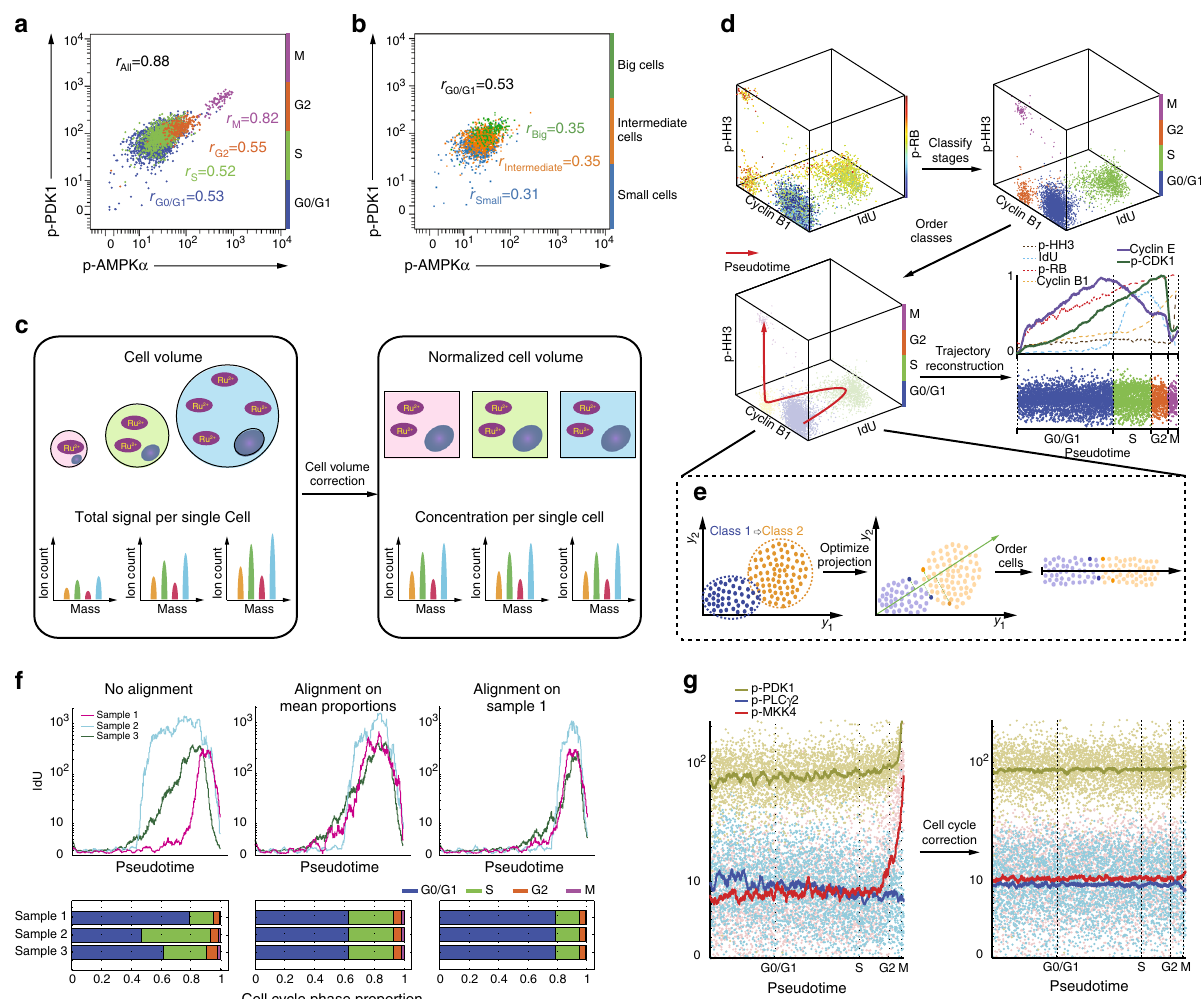
Fig. 1 Cell-volume and cell-cycle biases in mass cytometry data and their corrections using CellCycleTRACER. a Biaxial plot of p-PDK1 (Ser241) vs. p- AMPK α (Thr172) in THP-1 cells, where pre-gated cell-cycle phases are indicated by different colors. Computation of Pearson correlation coef fi cients across cell-cycle phases indicates a strong cell-cycle bias. b Biaxial plot of p-PDK1 (Ser241) vs. p-AMPK α (Thr172) in G0/G1 phase THP-1 cells that were pre- gated by cell volume as indicated by different colors. Pearson correlation coef fi cients are indicative of the cell-volume bias. c Cell-volume correction using ASCQ_Ru measurements removes cell-volume variability and transforms raw counts of measured markers into relative concentrations at single-cell resolution. d Construction of cell-cycle pseudotime initiates with automatic classi fi cation of the cells into discrete cell-cycle phases using measurements of IdU, cyclin B1, p-HH3, and p-RB25. The optimal trajectory across phases is constructed by projecting the data in a one-dimensional embedding function analogous to cell-cycle pseudotime. Mean trajectories of all measured cell-cycle markers across the reconstructed pseudotime recapitulate known behavior. Markers used to construct the pseudotime (IdU, cyclin B1, p-HH3, and p-RB) are shown as dashed lines, additional cell-cycle markers used as validation (cyclin E and p-CDK1) are shown as solid lines. e Simpli fi ed example of the trajectory reconstruction technique. By exploiting prior information of the class labels for each cell and the order of the classes, the best embedding function is computed by selecting the one that optimally preserves the known ordering across all cells in the new subspace de fi ned by the embedding. f CellCycleTRACER aligns cell-cycle pseudotime by equalizing cell-cycle phase duration across all analyzed samples. g CellCycleTRACER correction for cell-cycle redistributes the single cells independently of cell-cycle